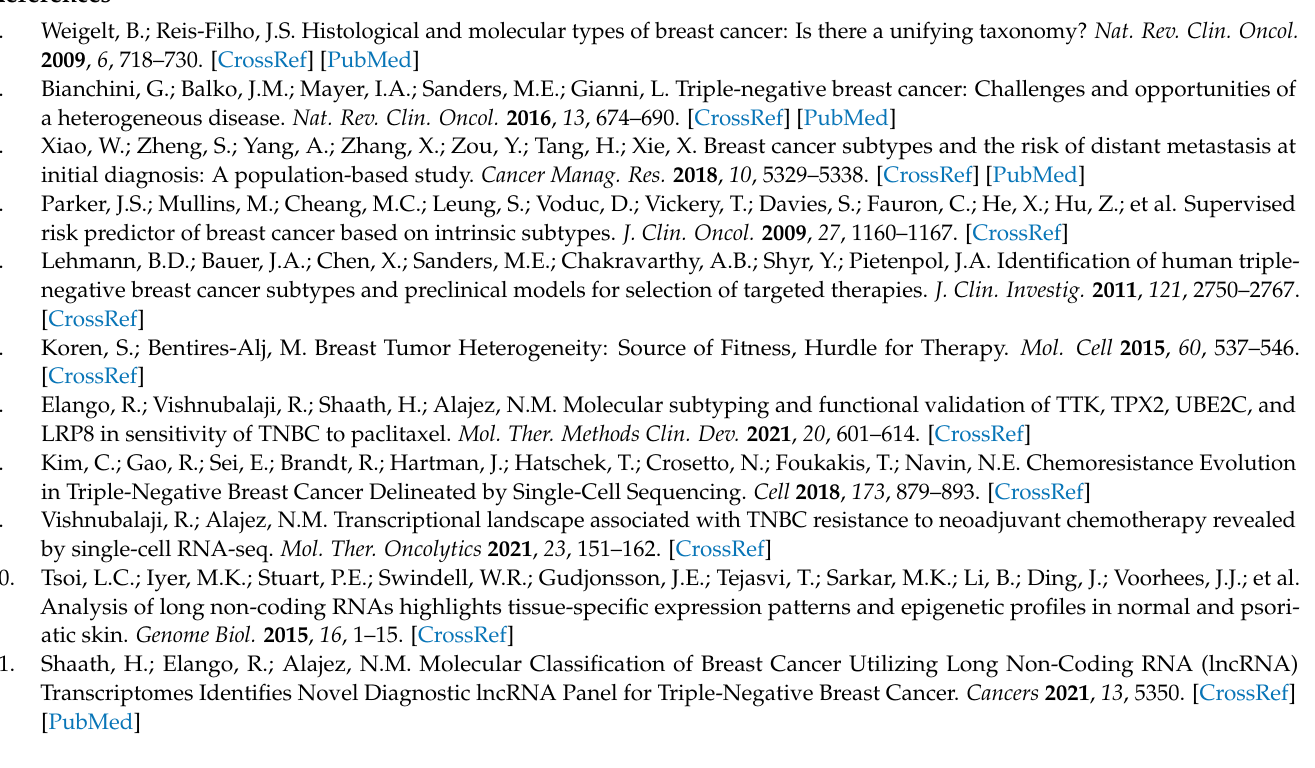
in the FIRRE-Enr cluster; Figure S2: PPI network for genes upregulated in the LINC00511-Enr cluster; Figure S3: PPI network for genes upregulated in the LINC00393-Enr cluster; Figure S4: PPI network for genes upregulated in the NT-like cluster; Figure S5: Prognostic value of lncRNA-based classifica- tion; Figure S6: Effect of CRISPR-Cas9 mediated LINC00511 promoter depletion on MDA-MB-157 colony formation and sensitivity to paclitaxel; Table S1: Differentially expressed lncRNA transcripts in TNBC (n = 360) vs. controls (n = 88) title; Table S2: Iterative Clustering and Guide-gene Selection (ICGS) classification of TNBC and normal BC; Table S3: Gene enrichment in the indicated TNBC or normal breast cluster; Table S4: Enriched gene ontology (GO) terms in the FIRRE-Enr TNBC cluster based on STRING analysis; Table S5: Enriched gene ontology (GO) terms in the LINC00511-Enr TNBC cluster based on STRING analysis; Table S6: Enriched gene ontology (GO) terms in the LINC00393-Enr TNBC cluster based on STRING analysis; Table S7: Enriched gene ontology (GO) terms in the NT-like TNBC cluster based on STRING